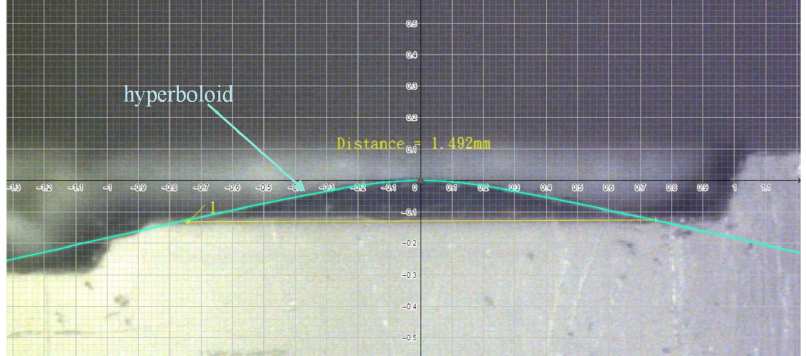
Figure 9. Conic section observed on microscope with scale grid on eyepiece.